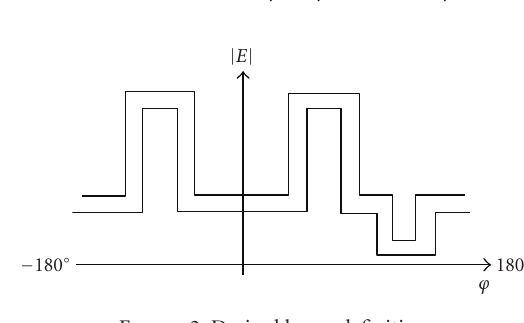
Figure 2: Desired beam definition.